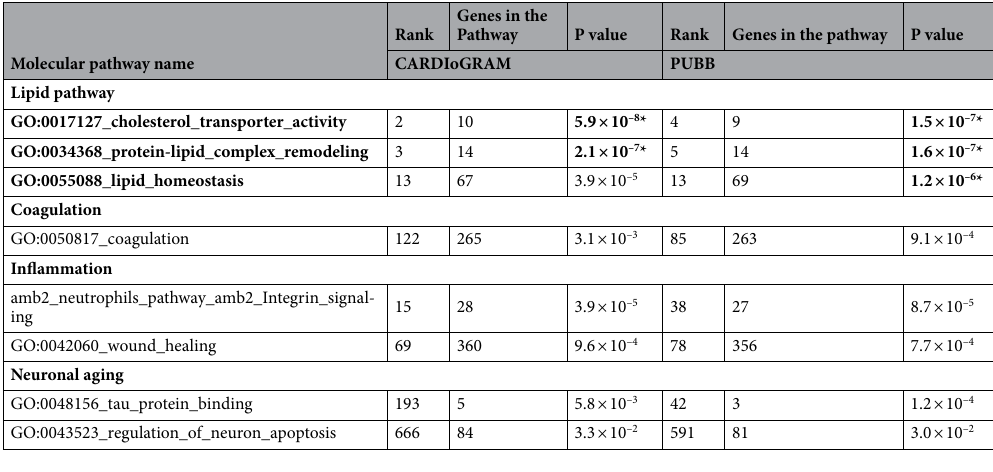
Table 5. Top one percent MAGMA lipid and non-lipid based enriched pathways in CARDIoGRAM (CGEX) or Pan UK Biobank (PUBB). GO gene ontology, PUBB Pan UK Biobank. *Pathways in bold with empirical pathway significance threshold was defined was p ≤ 5 × 10 –6